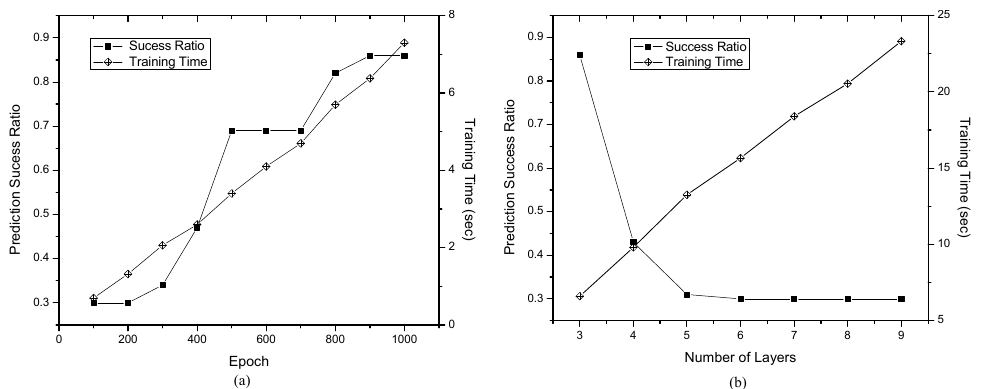
Figure 3. Comparison of Prediction Success Ratio: ( a ) Numbers of Epochs and ( b ) Numbers of DNN Layers.